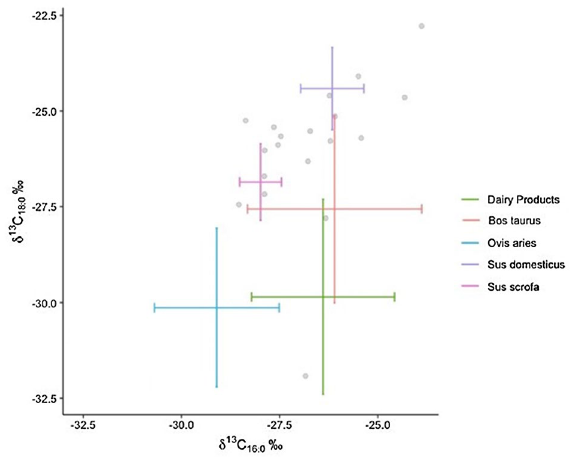
Figure 4. Scatter plot showing δ 13 C 16:0 ( X ) and Δ 13 C values ( Y ) of fatty acids extracted from Cabecicos Negros site compared with δ 13 C values from modern reference animal fat (Supplementary Material, STable